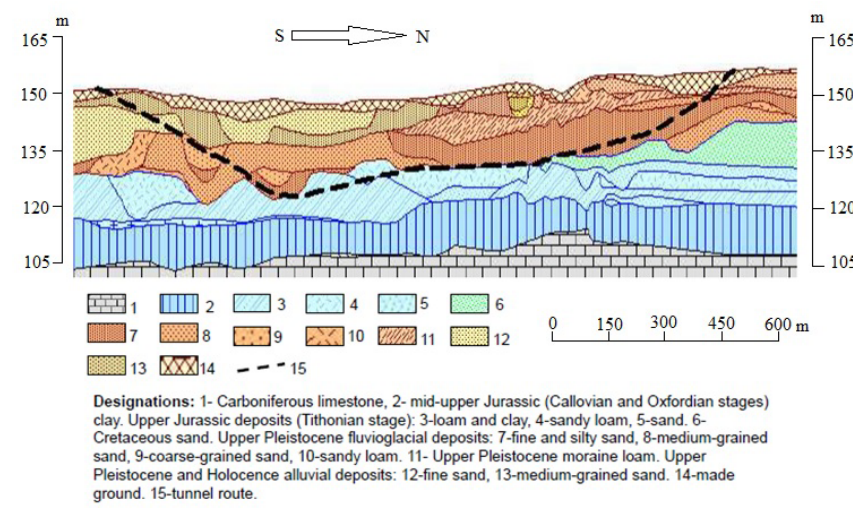
Figure 1. Geological cross-section along the route of Alabyan-Baltic tunnel in